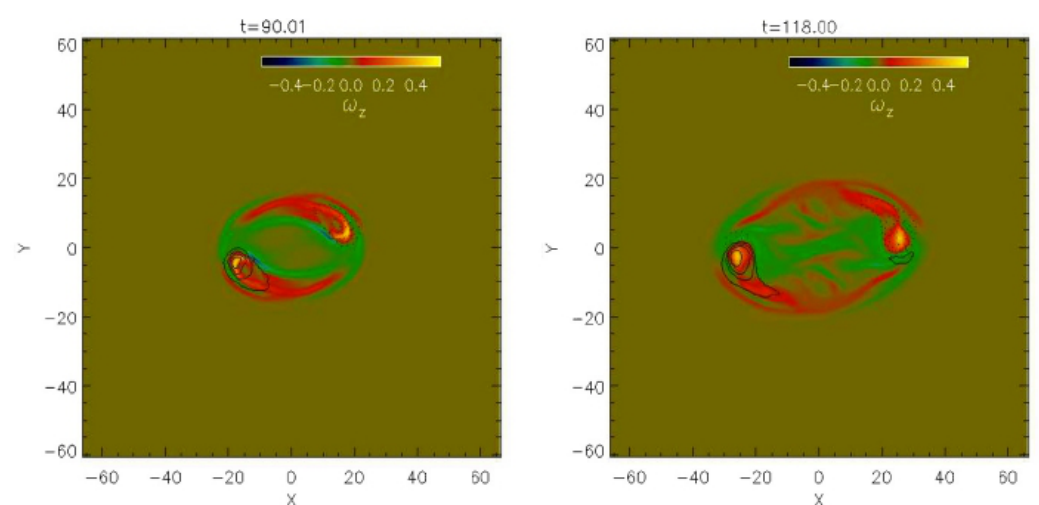
Figure 41: Distribution of the vertical component of vorticity ( 𝜔 𝑧 ) at the photospheric level at two different times in a numerical model of twisted flux tube emergence. In both panels, the two yellow patches are co-incident with the central portions of the twisted tube. Through they have opposite polarity, they have the same sign and amplitude of 𝜔 𝑧 . Image reproduced with permission from Fan (2009a), copyright by